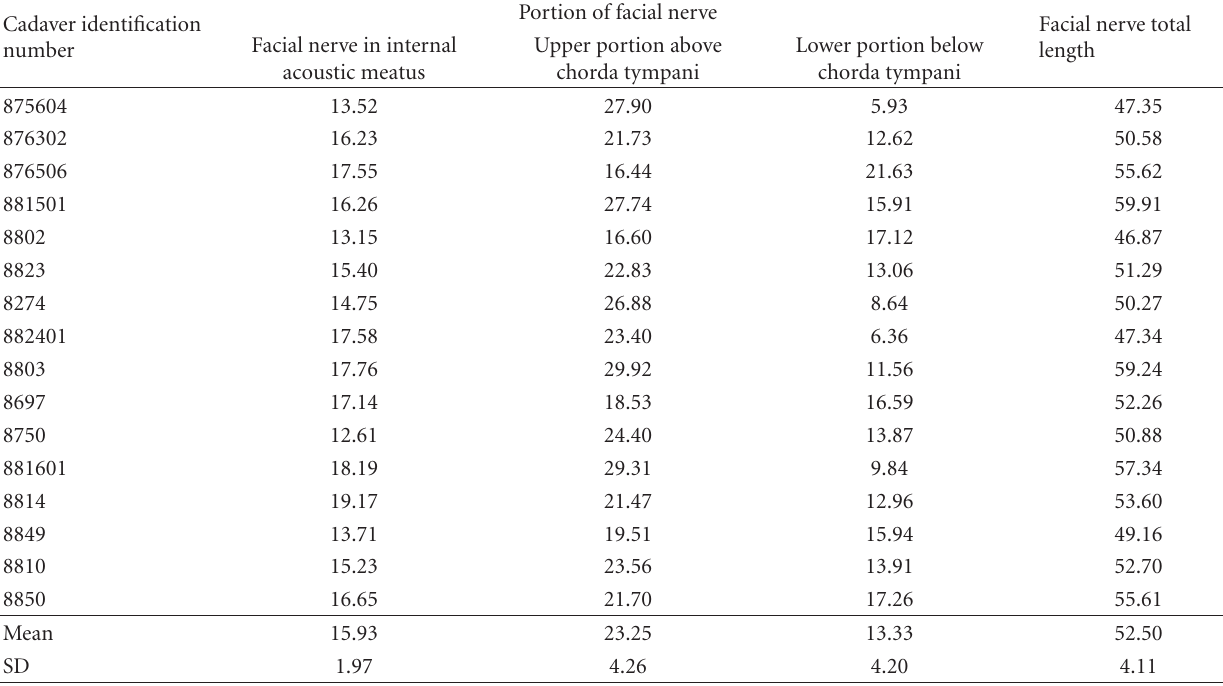
Table 2: Measurements of the facial nerve in millimetres.